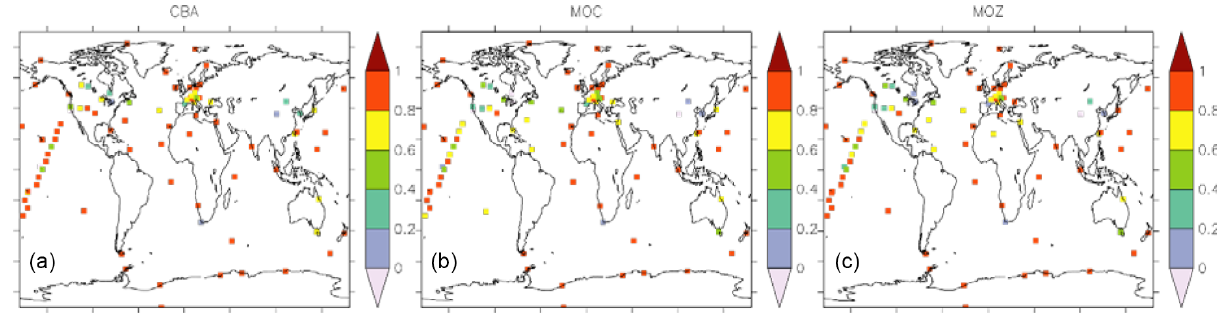
Figure 11. Temporal correlation ( R 2 ) between monthly mean surface CO as derived from observations (GAW network) and model simula- tions ( a : CBA, b : MOC, c :